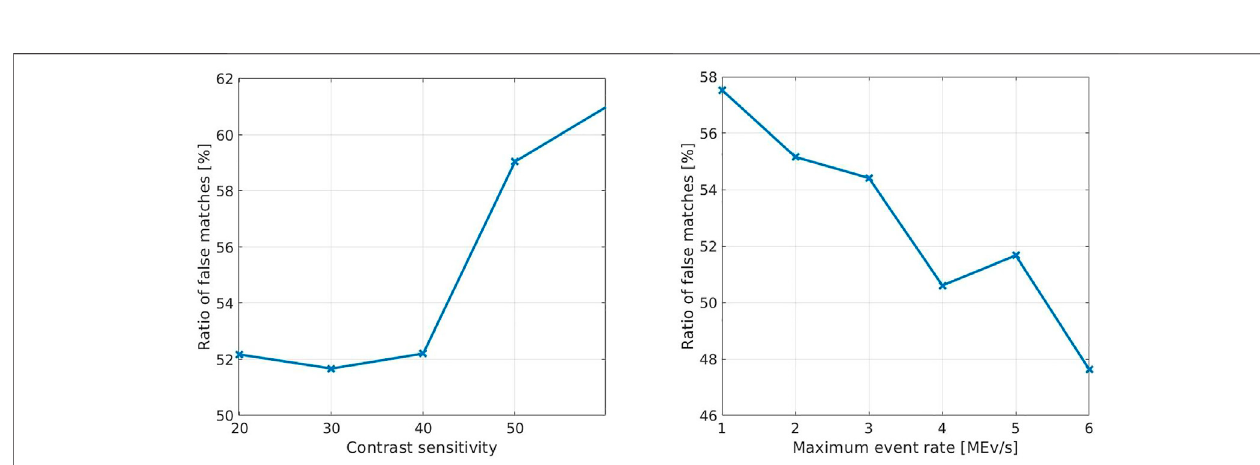
FIGURE 7 | Relative representation of false matches over several experiments with different camera parameters. How contrast sensitivity affects the algorithm ’ s results is shown on the left and how the results relate to the maximum event rate is shown on the right.